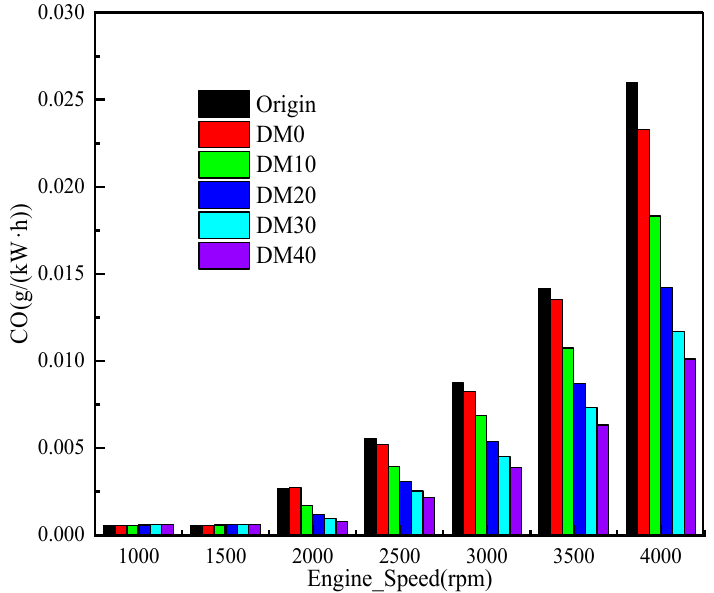
Figure 11. Effect of different ratios of methanol-diesel mixtures on CO emission at different speeds.